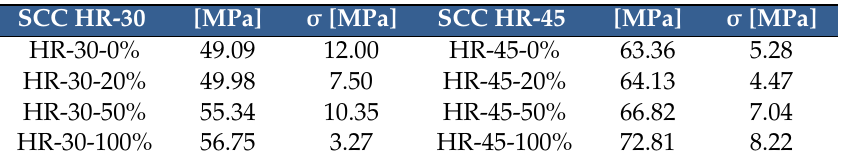
Table 2. Results of compressive strength and standard deviation σ